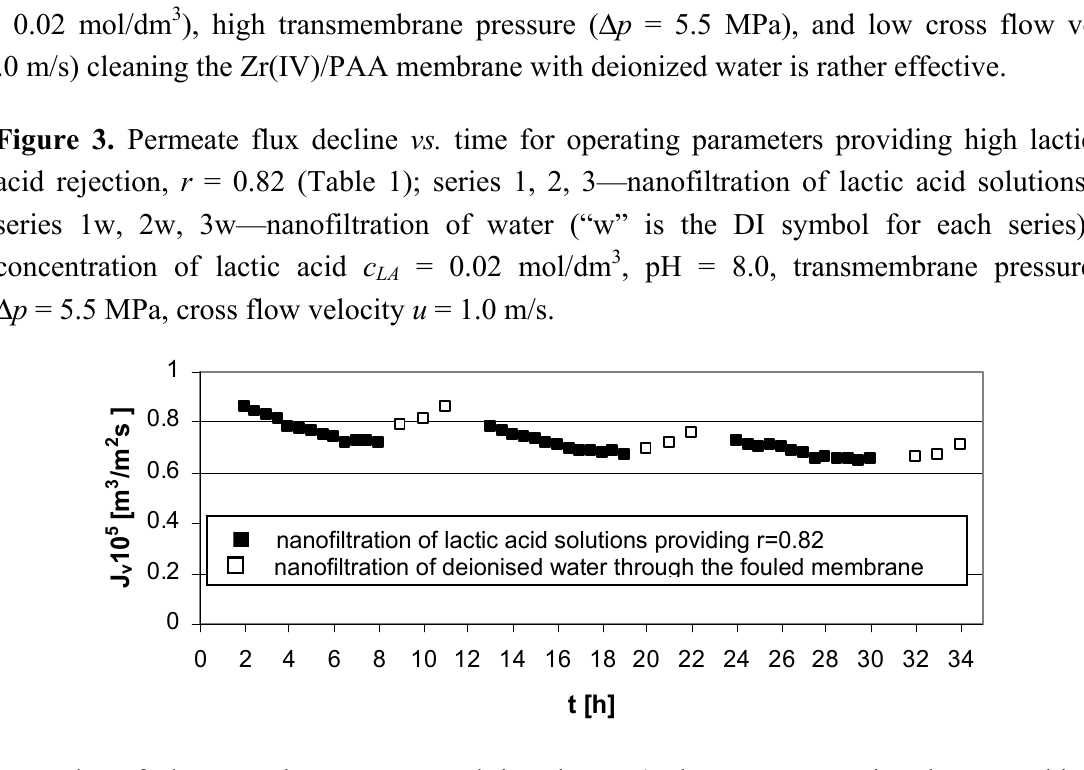
Figure 4. Permeate flux decline vs. time for operating parameters providing high lactic acid rejection, r = 0.58 (Table 1); series 1, 2, 3—nanofiltration of lactic acid solutions; series 1w, 2w, 3w—nanofiltration of water; concentration of lactic acid c pH = 8.0, transmembrane pressure Δ p = 5.5 MPa, cross flow velocity u = 2.6 m/s.